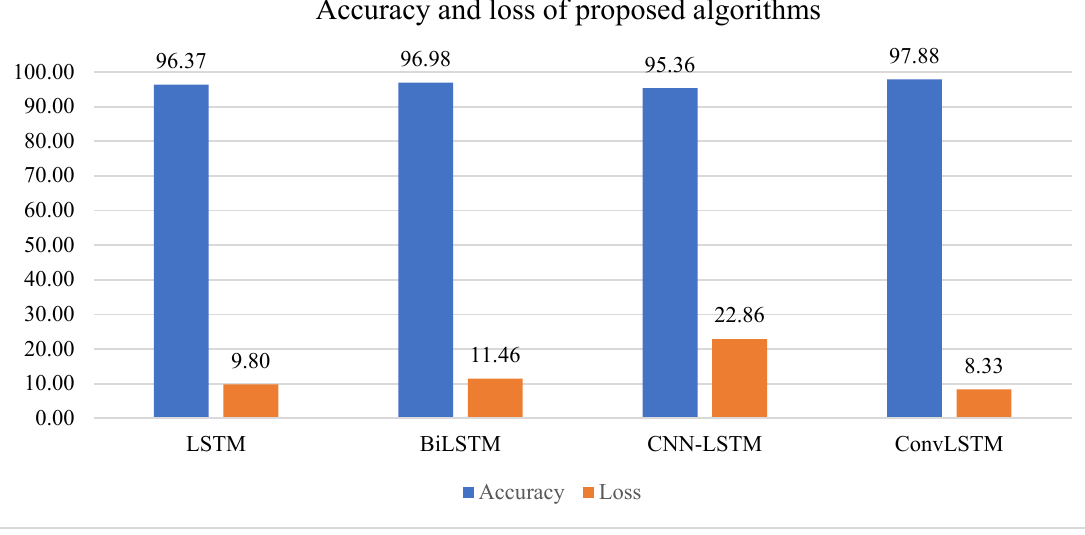
Table 3. Precision, Recall and F1 score .